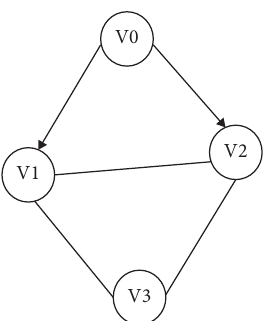
Figure 1: The topology of the leader-following multiagent system under the undirected graph.